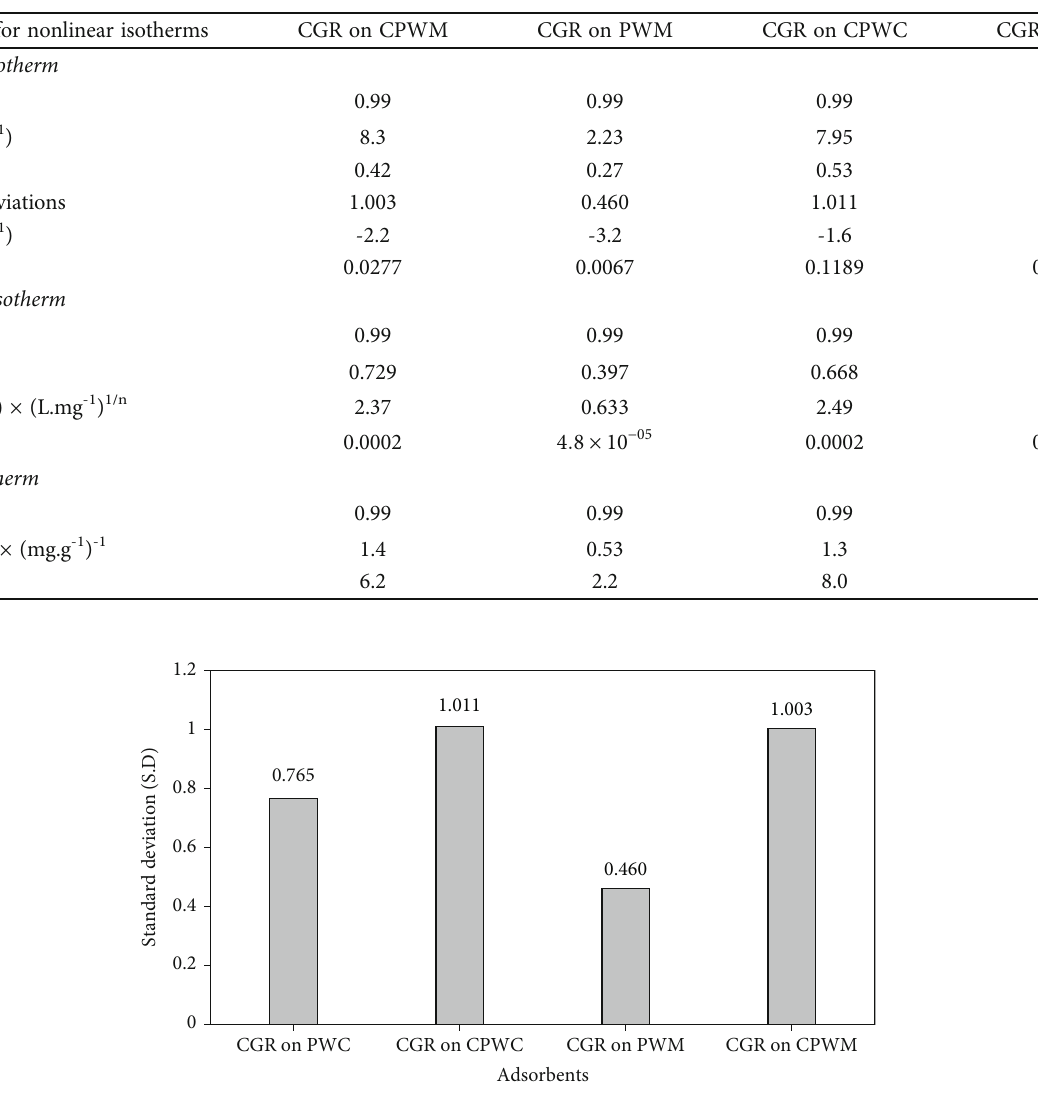
Table 3: A comparative nonlinear isothermal studies for the adsorptive removal of CGR.